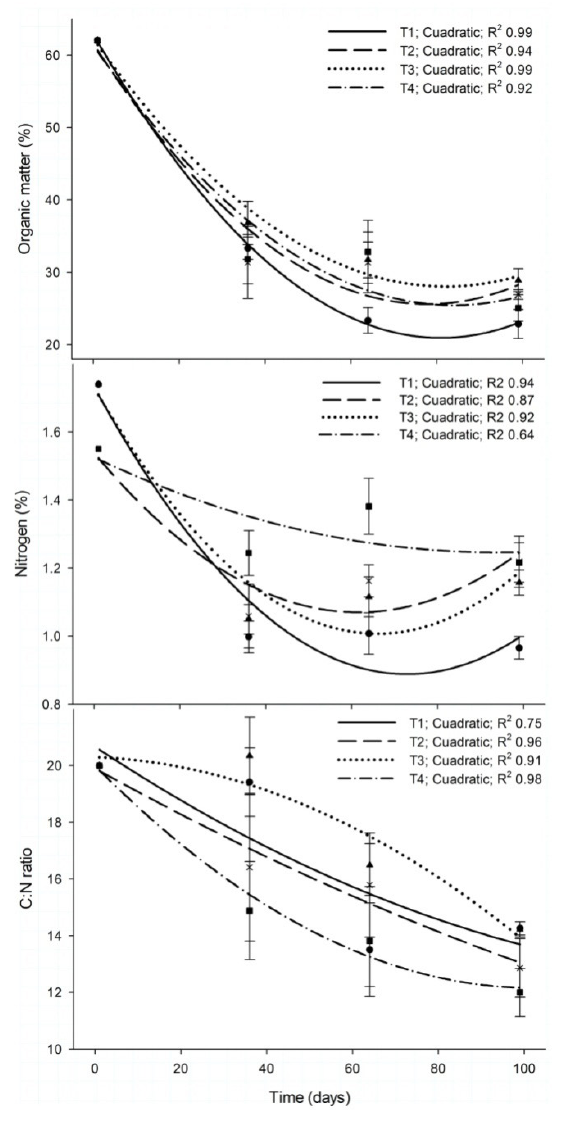
Figure 4: Organic matter, nitrogen (N) and C:N ratio of static piles (T1 ● prickly pear cactus+BP; T2 ᵡ moringa+BP; T3 ▲ prickly pear cactus; T4 ▀ moringa) over 100 days of analysis. Means (±SD) were calculated from five replicates for each treatment and sampling day. Statistically different (Tukey test, p<0.05)